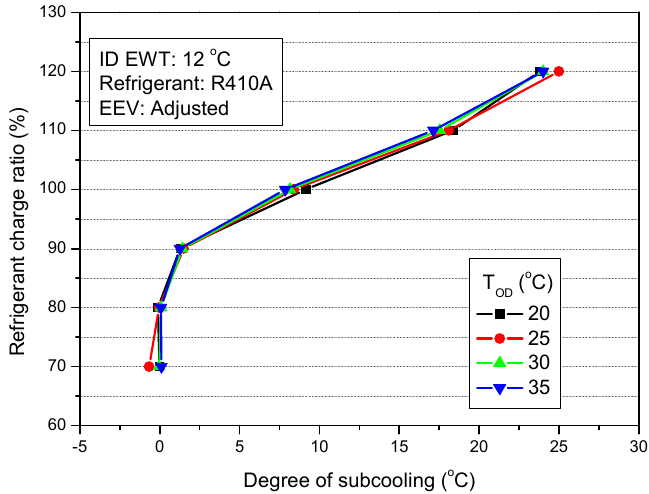
Figure 23. Relationship between the refrigerant charge ratio and degree of subcooling in cooling mode.